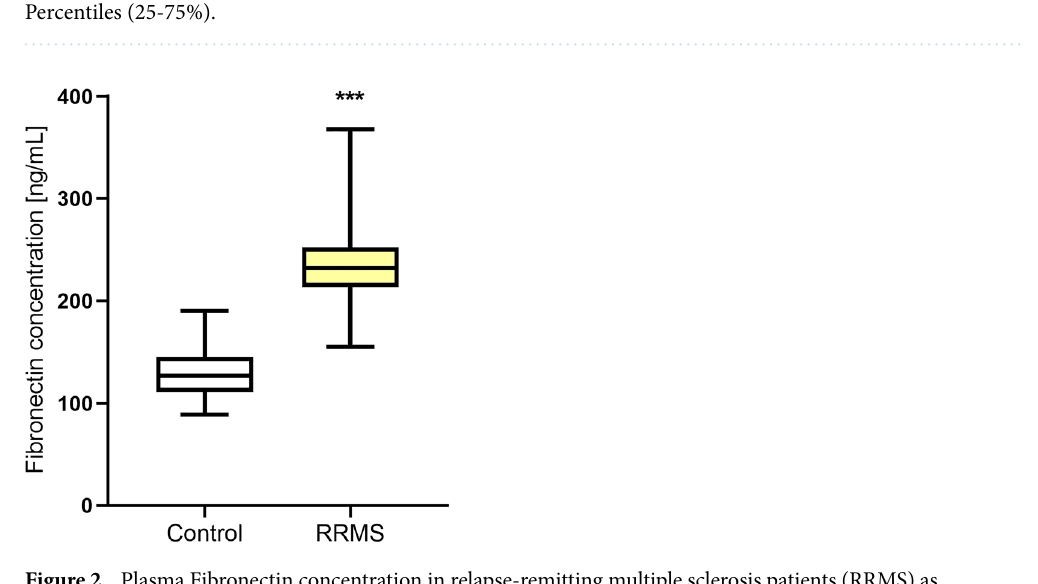
Figure 2. Plasma Fibronectin concentration in relapse-remitting multiple sclerosis patients (RRMS) as compared to the healthy control individuals. Statistical significance ***p ≤